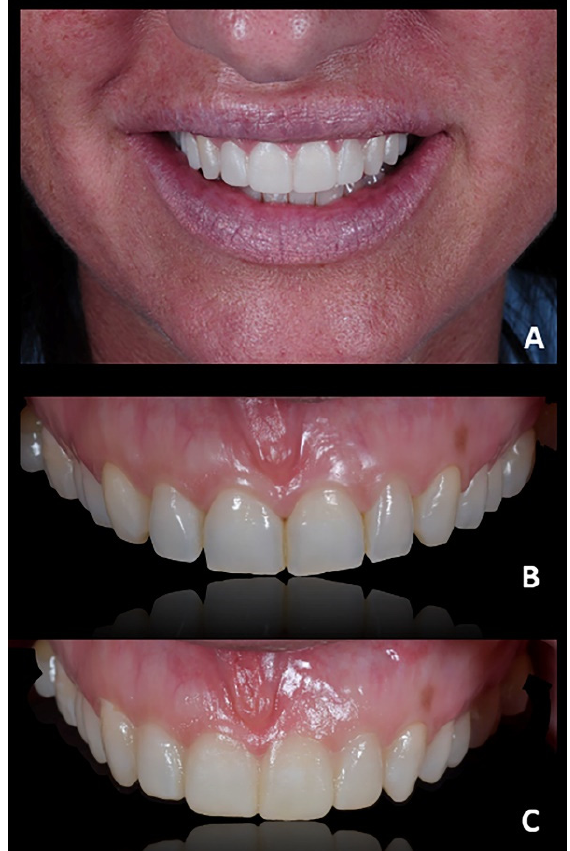
Figure 5. Case 1. ( A ) Pre-treatment composite mock-up; ( B ) dental alignment after orthodontic treatment; ( C ) final mock-up .